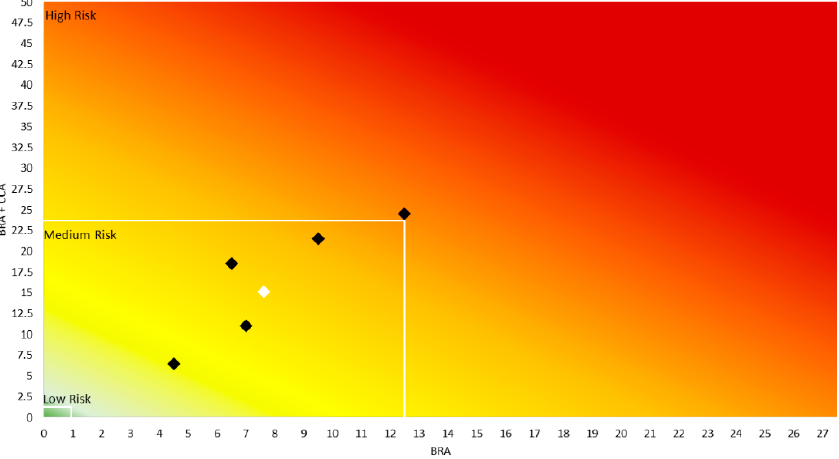
Figure 4. The risk matrix of BRA values against BRA + CCA values displays a gradient of “low risk” (green), “medium risk” (yellow), and “high risk” (red). Observations of the AS-ISK screening of Chilomycterus reticulatus are represented by black and white squares: individual assessments in black ( n = 5) and the overall average result in white. The thresholds for low, medium and high risk are indicated in the figure with white lines (tropical fish threshold of 12.5 for BRA and 23.4 for BRA + CCA was used).